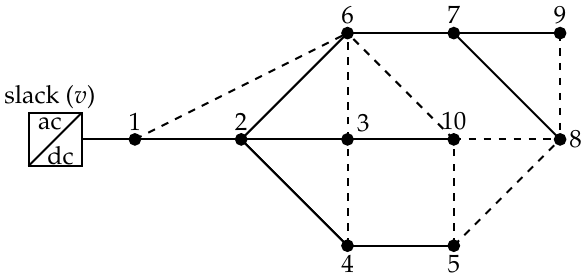
Figure 2. Electrical configuration for the 10-nodes test